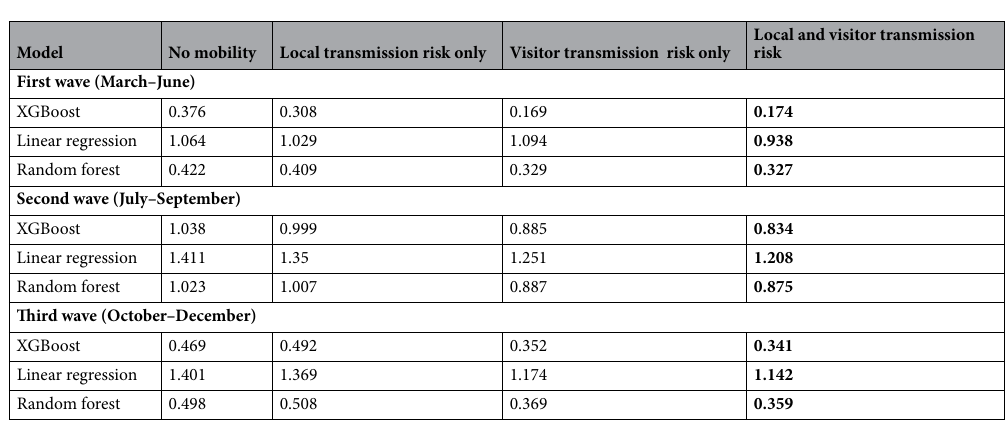
Table 2. Comparison of RMSE to forecast the number of cases with and without visitor transmission risk for various machine learning models. Best scenario for each machine learning approach is highlighted in [bold].